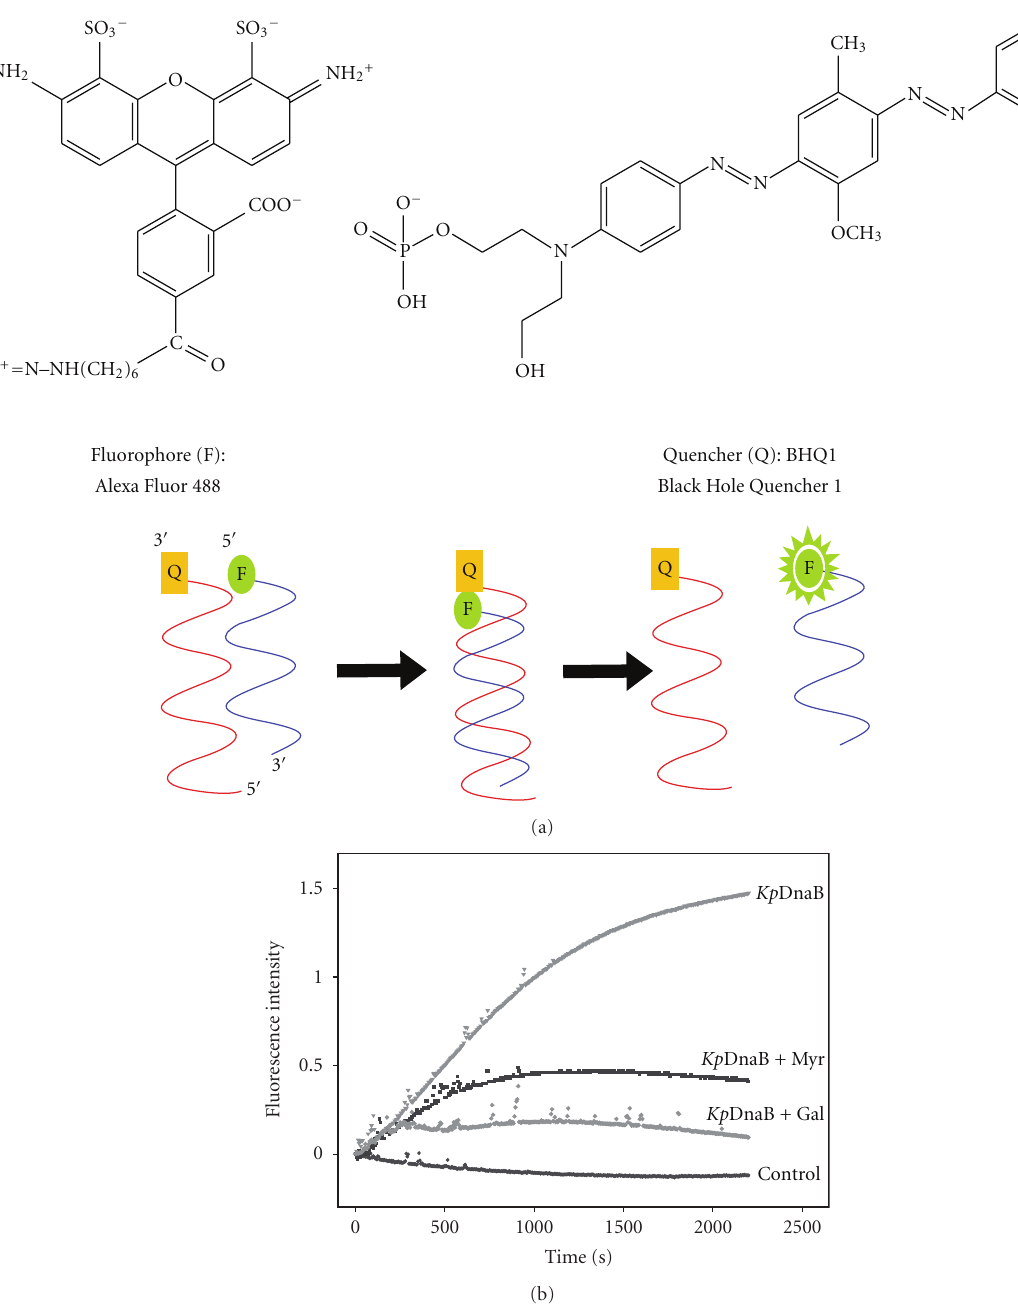
Figure 6: Real-time monitoring of Kp DnaB helicase activity. (a) Schematic representation of fluorescence helicase assay based on FRET. The dsDNA substrate was prepared by annealing 2 oligonucleotides, a 5 (cid:2) fluorophore-labeled (Alexa Fluor 488) 22-nucleotide donor, and a 3 (cid:2) quencher-labeled (BHQ1) 36-nucleotide quencher. When the dsDNA substrate is unwound by the helicase, the fluorophore (F) emits upon its release from the quencher (Q). (b) Inhibitory e ff ects of flavonols on Kp DnaB helicase activity. Myr and Gal were selected for this assay.